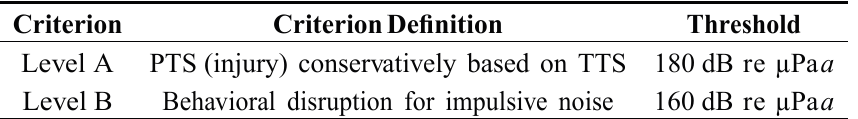
Table 1 : National Oceanic and Atmospheric Administration fisheries current in-water acoustic thresholds